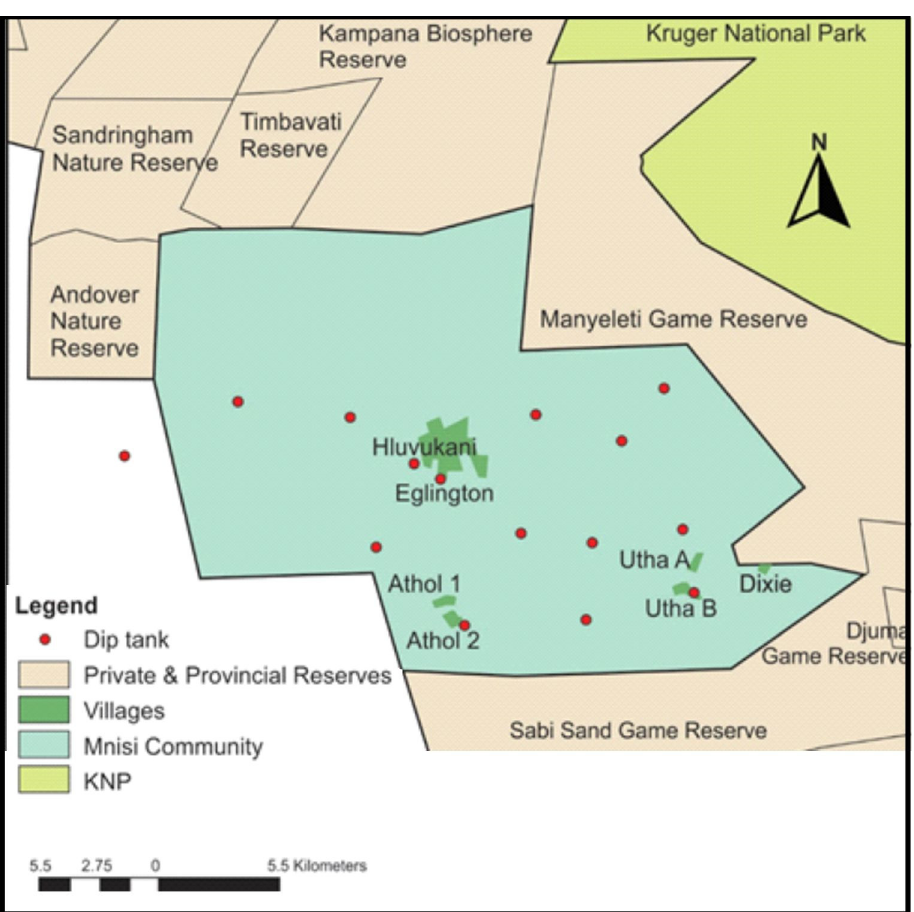
Figure 1. Map of the Mnisi communal area, showing the location of the three villages where the study was conducted, Eglington, Utha A, and Dixie, relative to various wildlife reserves and the Kruger National Park (KNP).